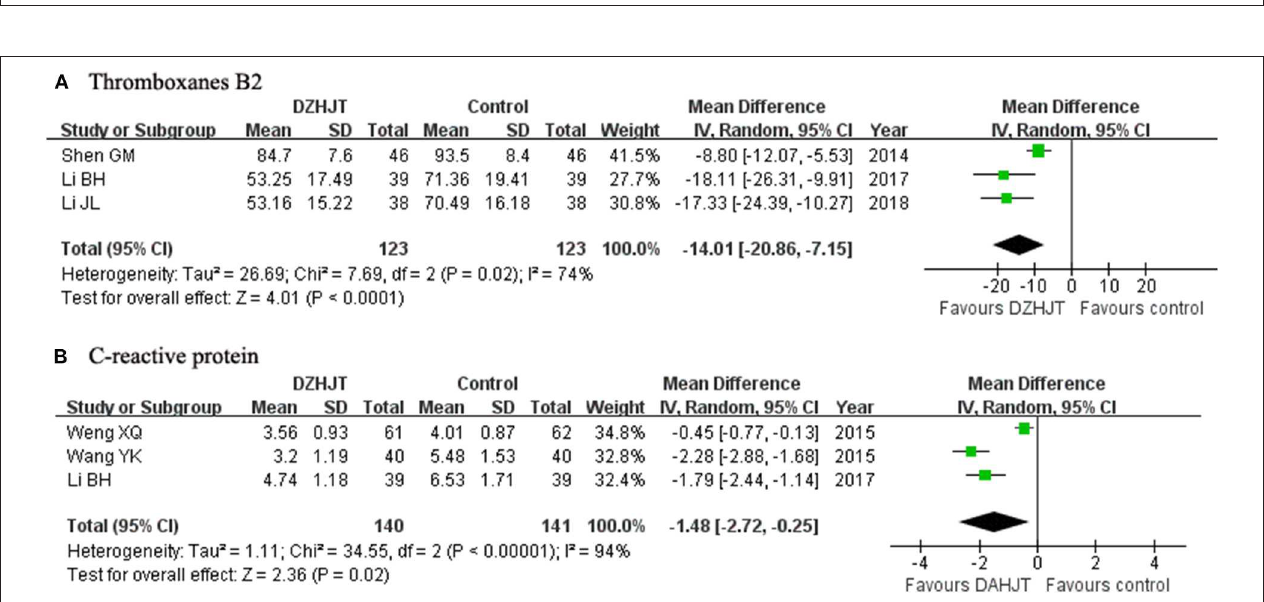
FIGURE 5 | Forest plots showing comparison of the serum thromboxanes B2 (A) and C-reactive protein (B) level in patients with or without DZHJT treatment.